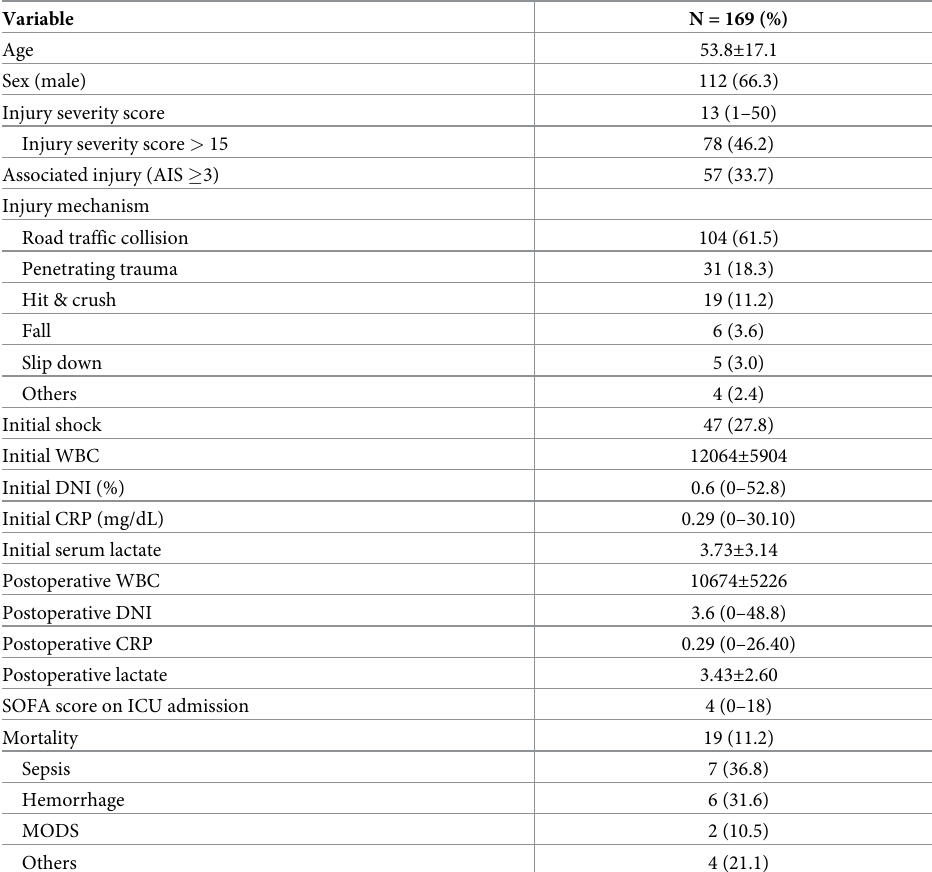
Table 1. Patient